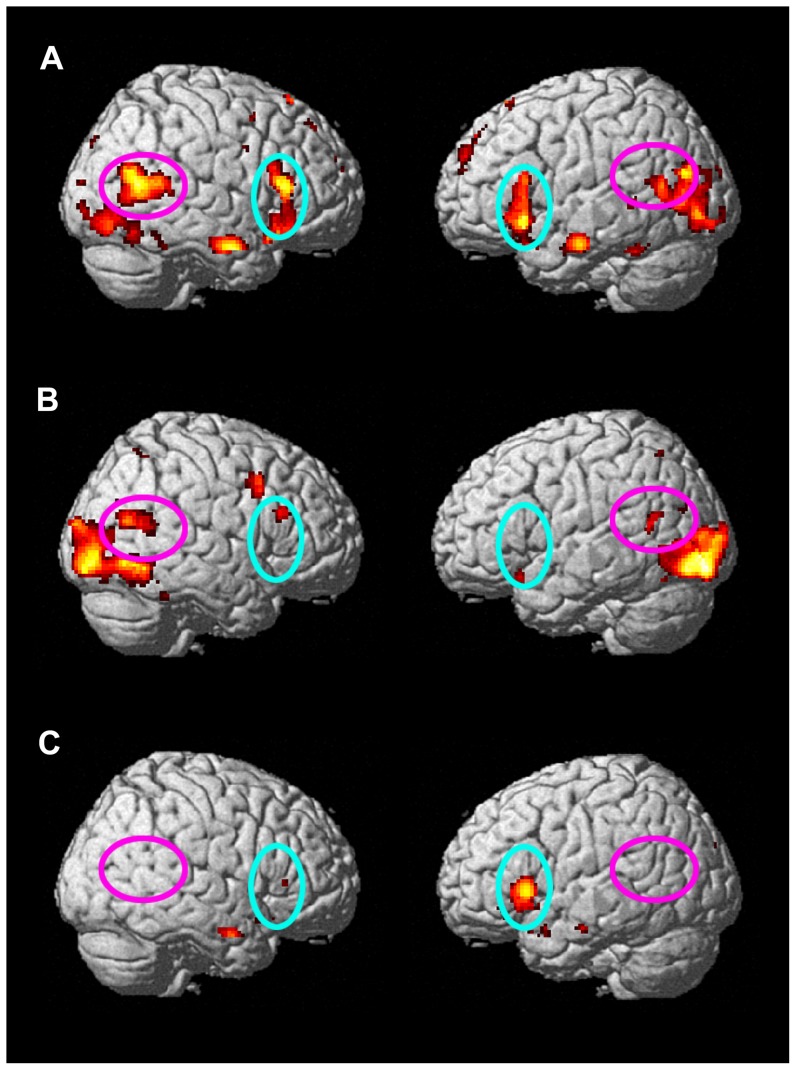
Activation maps for (a) Typically developing (TD) participants: Social – Physical; (b) Participants with Autism (AD): Social – Physical; and (c) TD – AD, Social – Physical.The IFG is circled in aqua, and the pSTS is circled in magenta.